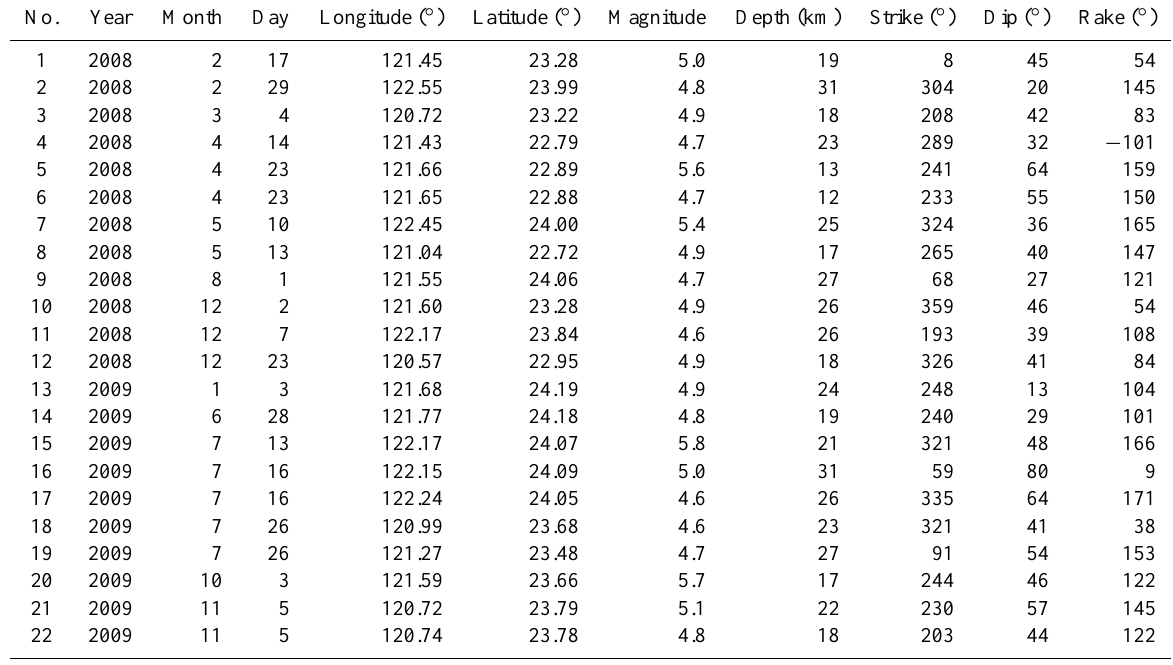
Table 1. Source parameters of the source events for calculating seismicity rate change using the rate-and-state friction model. No.